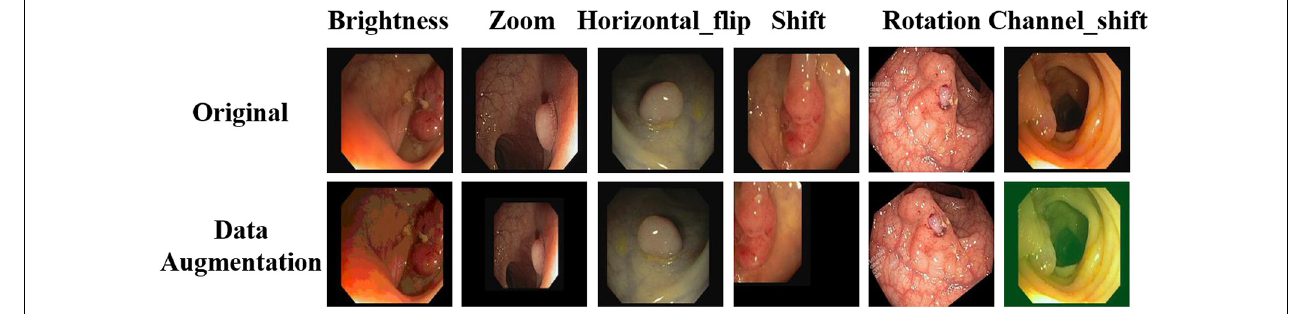
FIGURE 4 | Image enhancement